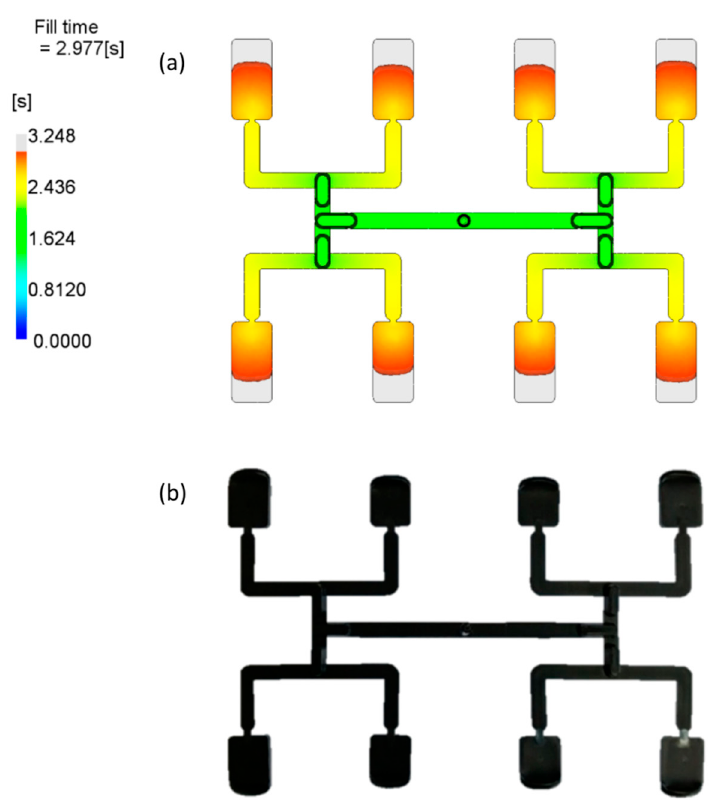
( a ) simulation, ( b ) experiment. Figure 9. Results of simulation and experimentation for the optimum set of data (by Taguchi):